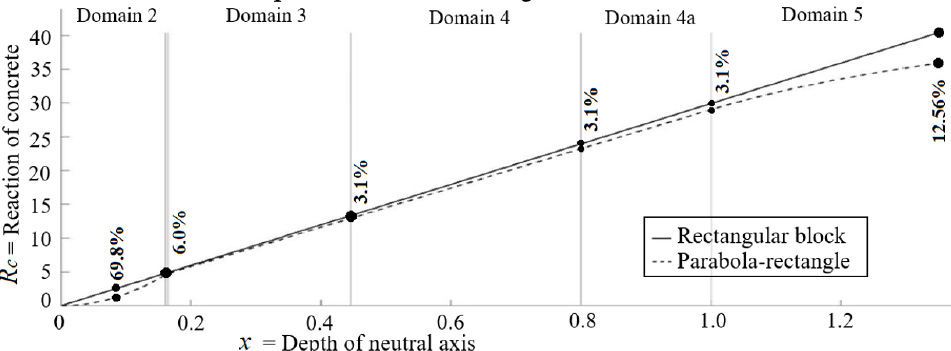
Figure 7. Internal reaction for concrete class C80 ( f ck = 80 MPa). The percentage di ff erence between the two approaches is marked at some representative points, referred to results obtained with the parabola-rectangle dia-